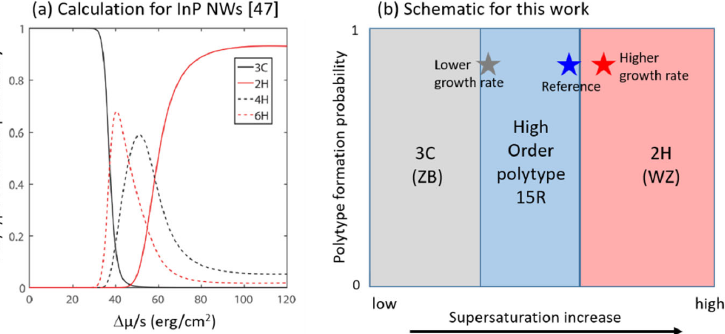
Figure 13. ( a ) Polytype formation probability as a function a supersaturation in InP NWs, reprinted with permission from Ref. [47]. Copyright {2016}, American Chemical Society, and ( b ) Illustration of supersaturation effect on polytype formation probability in ZnS NWs. The gray, blue, and red stars correspond to ZnS NWs experiments with various growth rates.